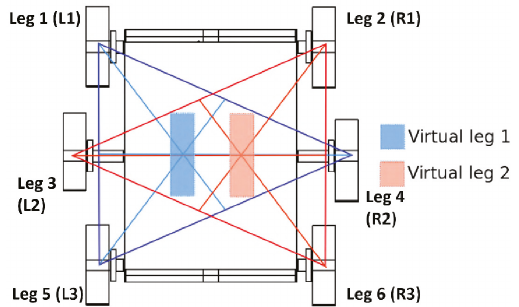
Figure 5. CLHeRo 2.5: Tripods and virtual legs.